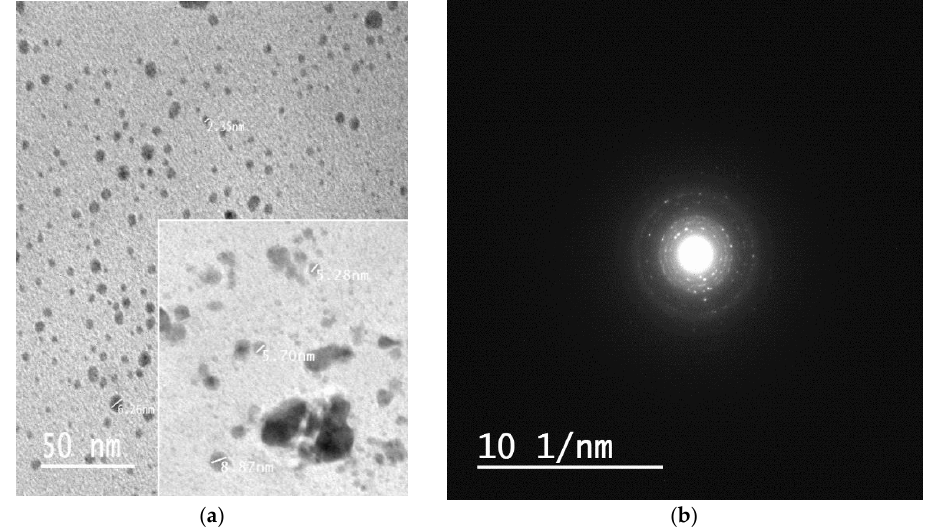
Figure 7. TEM and SEAD micrographs of prepared silver nanoparticles within chitosan/silver– curcumin hydrogel ( a , b ). hydrogel ( a , b